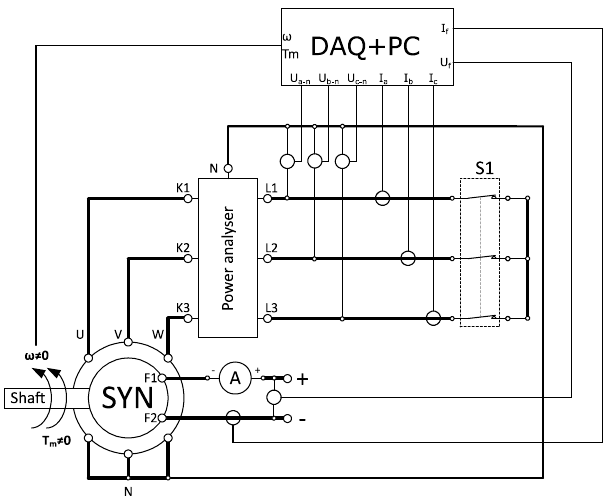
Figure 4. Diagram of the measurement setup for short-circuit and voltage recovery tests.